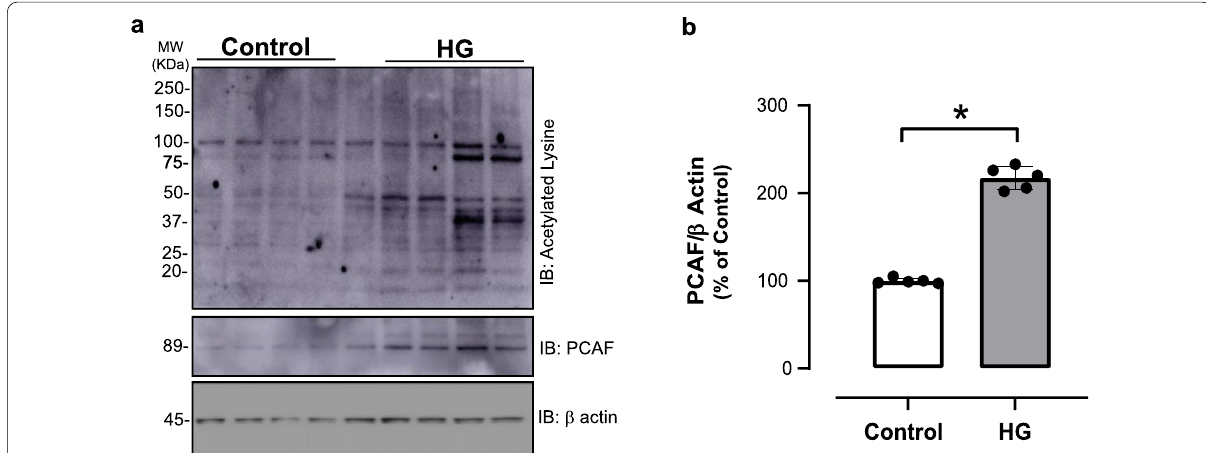
Fig. 6 High glucose increases levels of lysine acetylation and PCAF expression in primary human VSMCs cultures. Human VSMCs (hVSMC) were stimulated with 25 mM high glucose (HG) for 12 h. a Global lysine acetylation was detected by using a specific antibody for acetylated lysine residue. β actin used as internal control. b Bar graphs are means SEM for PCAF expression as determined from densitometry relative to internal ± control. β tubulin used as internal control. *p < 0.05 vs. control, n 5 per group. Molecular weight =